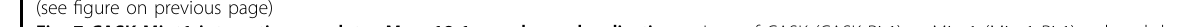
Fig. 7 CASK-Mint1 interaction regulates Munc18-1 membrane localization. a Loss of CASK (CASK Ri-1) or Mint1 (Mint1 Ri-1) reduced the membrane localization of Munc18-1 which was detected by immuno fl uorescence using anti-Munc18-1 (green) (upper panel). Represented peak curve diagrams showing cellular distribution on membrane (m) and in cytoplasm of Munc18-1 immuno fl uorescent signals measured by Image J with linear scanning (lower panel). b Subcellular fractionation con fi rmed the increase of Munc18-1 in cytosolic fraction. and decrease in membrane fraction (M) when CASK or Mint1 was silenced (Ci & Mi). Con, control; T, total lysate. Ecadherin, LaminB and Tubulin were used as markers for membrane, nucleus and cytosol respectively (middle panel). The signals of Munc18-1 were quanti fi ed using a densitometer (right panel). c Overexpressing Mint1 4A mutant but not wild type (WT) Mint1 disrupted the membrane localization of Munc18-1 which was detected by immuno fl uorescence using anti-Munc18-1 (green) (upper panel). Represented peak curve diagrams showing cellular distribution on membrane (m) and in cytoplasma of Munc18-1 immuno fl uorescent signals measured by Image J. with linear scanning (low panel). *For a and c cells were treated with glucose. *For a and c , Z-projection in the X – Z direction and in the Y – Z direction are shown. The green and red lines indicate the orthogonal planes of the X – Z and Y – Z projection, respectively. *Note the different distribution pattern of Munc18a in different situations showed by the low panels of a and c . d Fractionation assays by gel fi ltration chromatography revealed co-fractionation of CASK, Mint1 and Munc18 in INS-1E cells transfected with non-silencing control siRNA (NC), CASK-speci fi c siRNA (CASK Ri-1) or Mint1-speci fi c siRNA (Mint1 Ri-1). After being stimulated with glucose, the lysate was fractionated by gel fi ltration chromatography using a Superose 6 10/300 GL column. The western blot images were showed for the representative fractions of Paek1 and Peak2 from INS-1E cell transfected with NC (i), Mint1 Ri-1(ii) and CASK Ri-1(iii). Eluted protein pro fi les from each fraction were quanti fi ed and normalized to T (total protein) for CASK, Mint1 and Munc18 (iv-vii) in INS-1E cells transfected with NC, CASK Ri-1 or Mint1 Ri-1, respectively. e The hypothetical